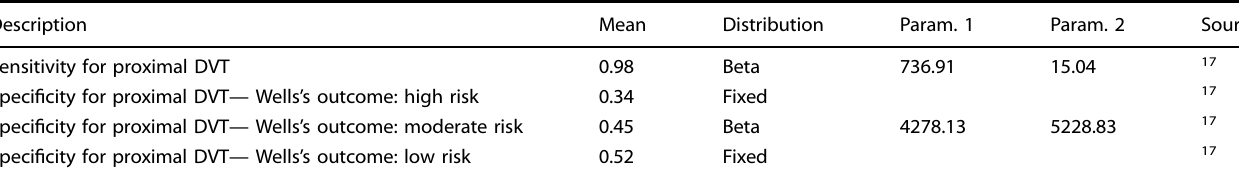
Table 11. Test Ef fi ciency D-dimer test.